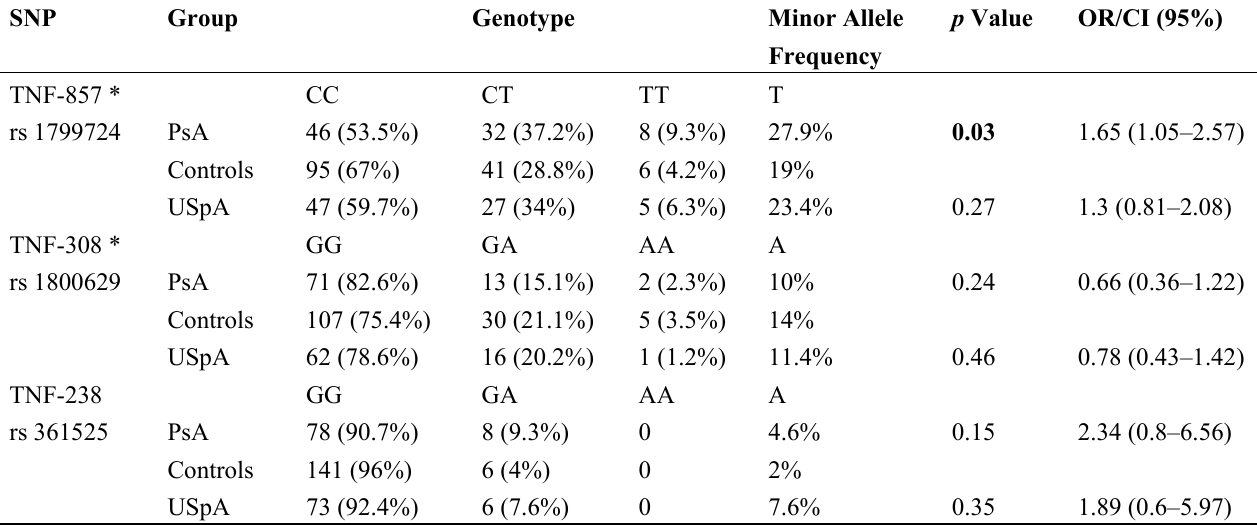
Table 1. Genotype distribution and allele frequencies of the tumor necrosis factor (TNF)-alpha gene promoter polymorphisms for psoriatic arthritis ( n = 86), undifferentiated spondyloarthritis ( n = 79) and controls ( n = 147). OR, odd ratio; CI, 95% confidence interval for OR. * Data available for 142 control